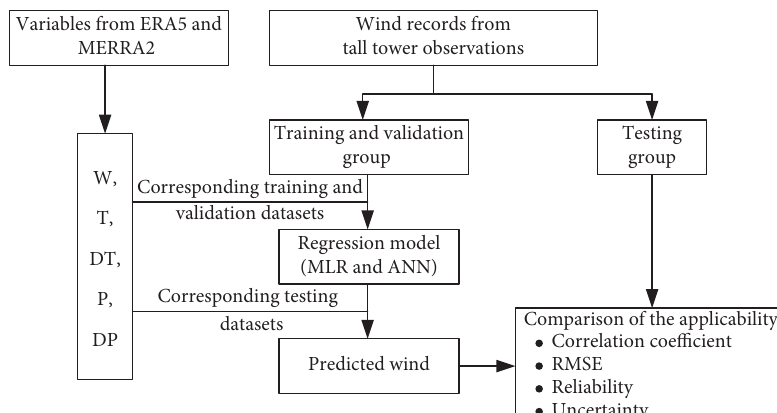
Figure 3: Research flowchart. Five variables of the reanalysis were selected as model inputs, including W the reanalysis wind speed; T 2- meter air temperature; DT: hourly variation in the 2-meter air temperature; P surface pressure; DP: hourly variation in surface